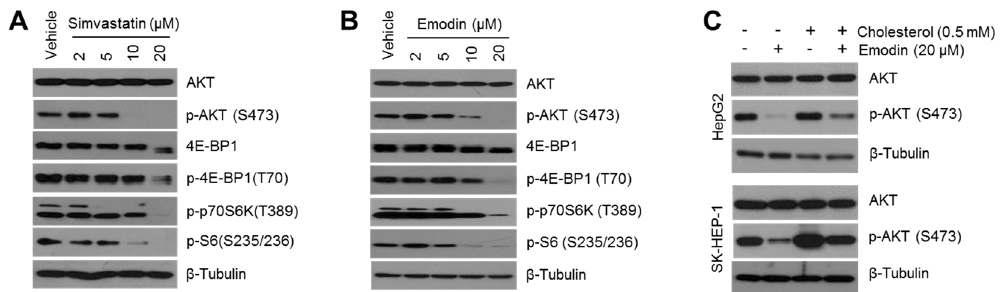
Figure 6. Decreased intracellular cholesterol level by emodin causes the suppression of the oncogenic protein kinase B (AKT) signaling pathway. ( A ) Simvastatin suppressed the AKT signaling pathways. SK-HEP-1 cells were incubated with different concentrations of simvastatin (2, 5, 10, and 20 µ M) for 12 h. ( B ) Emodin suppressed the phosphorylation of AKT and its target substrates. SK-HEP-1 cells were incubated with emodin (2, 5, 10, and 20 µ M) for 12 h. ( C ) The supplementation of water-soluble cholesterol rescued the decreased phosphorylation of AKT caused by emodin. SK-HEP-1 and HepG2 cells were incubated in the presence or absence of 0.5 mM cholesterol for 1 h prior to emodin treatment. Subsequently, the cells were incubated for a further 12 h, and protein expression was measured by Western blotting.